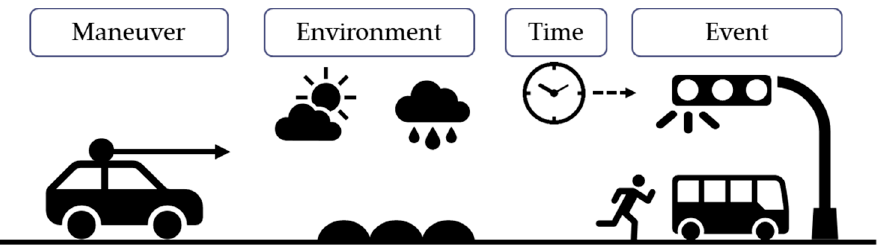
Figure 2. Four components of driving—maneuver, environment, time, and event.